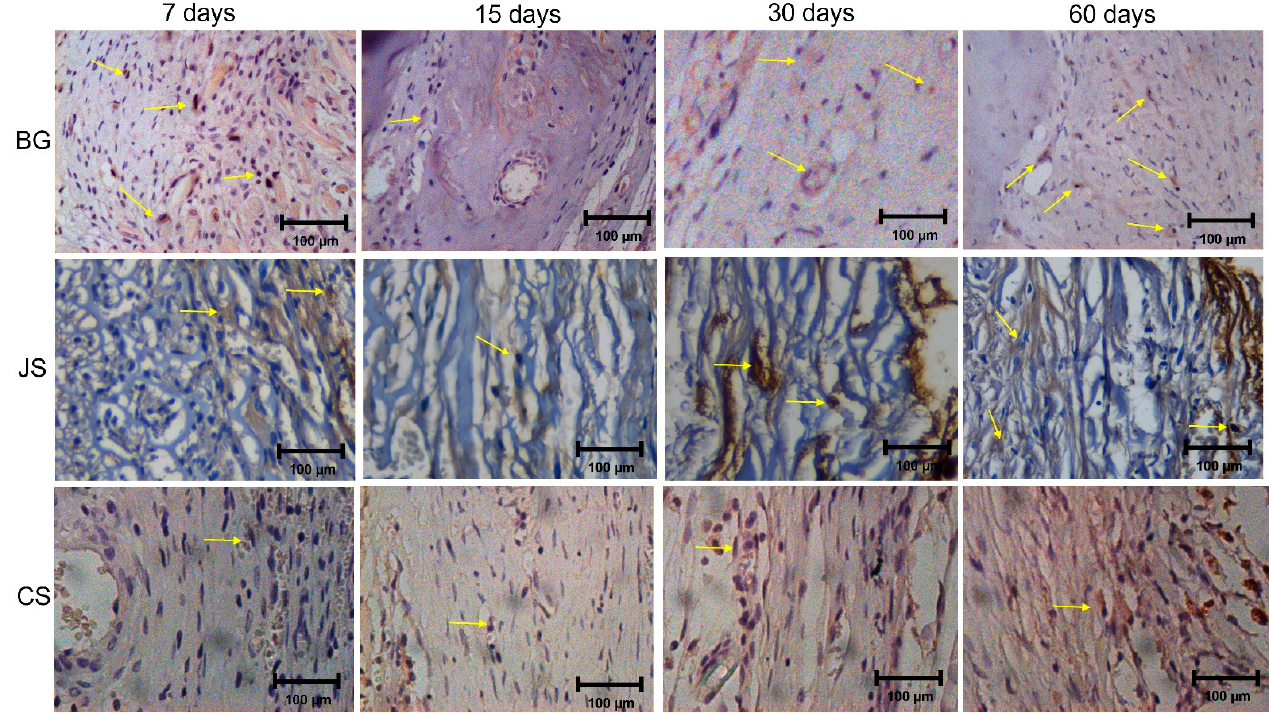
Figure 8. Photomicrographs of the immunohistochemical analyses at BG, JS, and CS group in 7, 15, 30, and 60 days highlight osteopontin reaction at 40.0× magnification. The yellows arrow indicates the labeling.